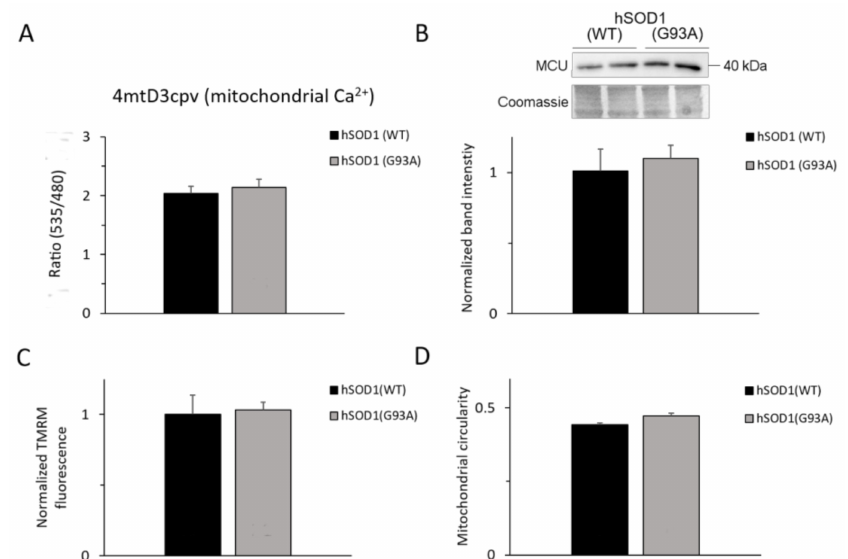
Figure 6. Mitochondrial Ca 2 + -related and morphologic parameters are una ff ected by the expression of hSOD1(G93A). For measuring the basal Ca 2 + level in the mitochondrial matrix ( A ), astrocytes were transfected with a plasmid encoding the mitochondrially-targeted cameleon probe 4mtD3cpv, and the FRET signal was measured 72 h after transfection. The expression level of the ion transporting subunit of the mitochondrial Ca 2 + uniporter (MCU) complex ( B ) was assessed by WB. The upper part of the panel shows a representative WB from two di ff erent astrocyte lysates for each hSOD1 genotype and the corresponding Coomassie blue staining, while the bar diagram in the lower part of the panel reports the densitometric analysis of MCU-immunoreactive bands (as described in Materials and Methods and the legend to Figure 2). A full-size image of the WB is reported in Figure S11. For measuring ∆ ψ m ( C ), astrocytes were loaded with the mitochondrial potentiometric tetramethyl-rhodamine methyl ester (TMRM) probe and the TMRM signal in mitochondria-rich regions was measured by means of a suited fluorescence microscope (for further details, see Materials and Methods). Reported data are normalized to the mean value of hSOD1(WT) astrocytes. For estimating mitochondrial morphology ( D ), astrocytes were transfected with a plasmid encoding a red-fluorescent protein targeted to mitochondria. 72 h after transfection, fluorescence images were collected by a confocal microscope, and mitochondrial circularity was calculated as described in Materials and Methods. None of the four measured mitochondrial parameters significantly di ff er between hSOD1(WT) and hSOD1(G93A) astrocytes (unpaired two-tailed Student’s t -test). Reported data are from at least 12 coverslips from at least 4 di ff erent primary cultures (panels A, C and D) or from 6 di ff erent primary cultures (panel B) for each hSOD1